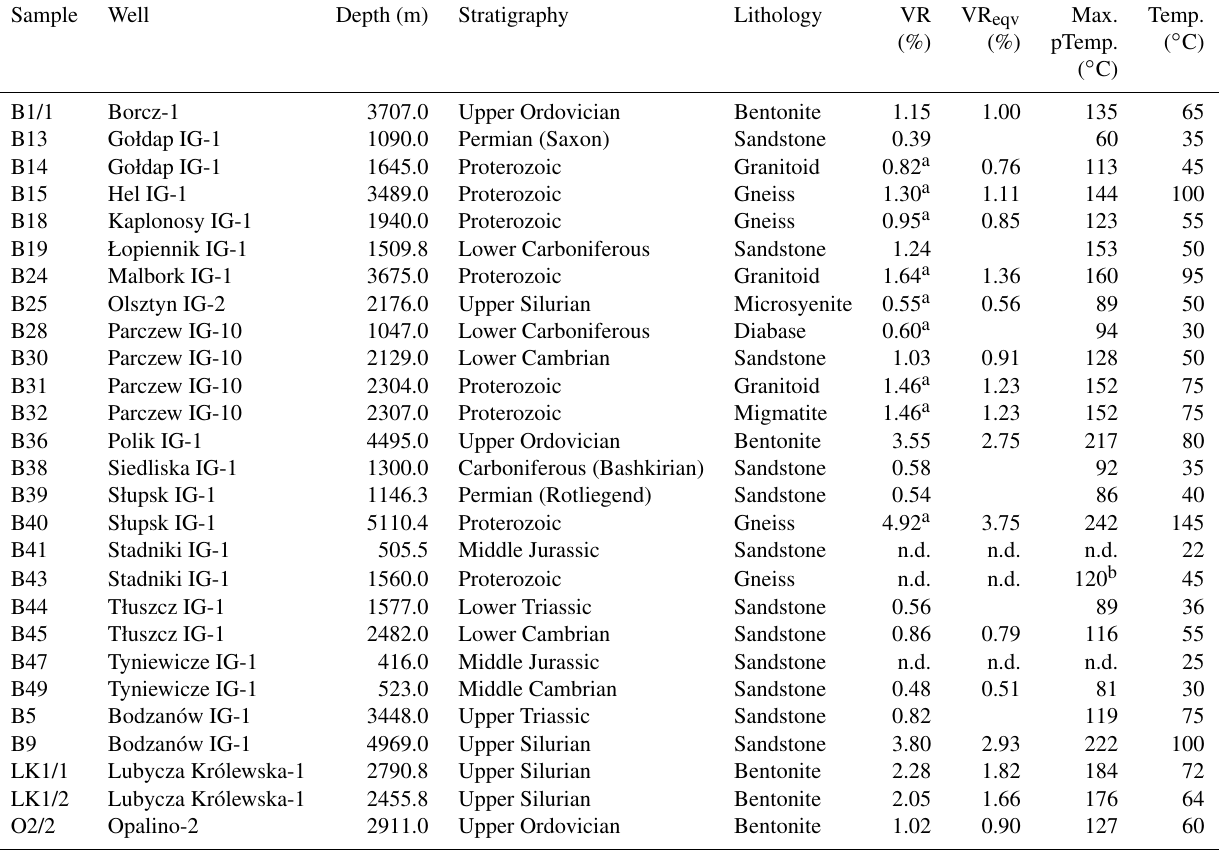
Table 1. Locality, stratigraphy, lithology, temperature, and thermal maturity of the samples.